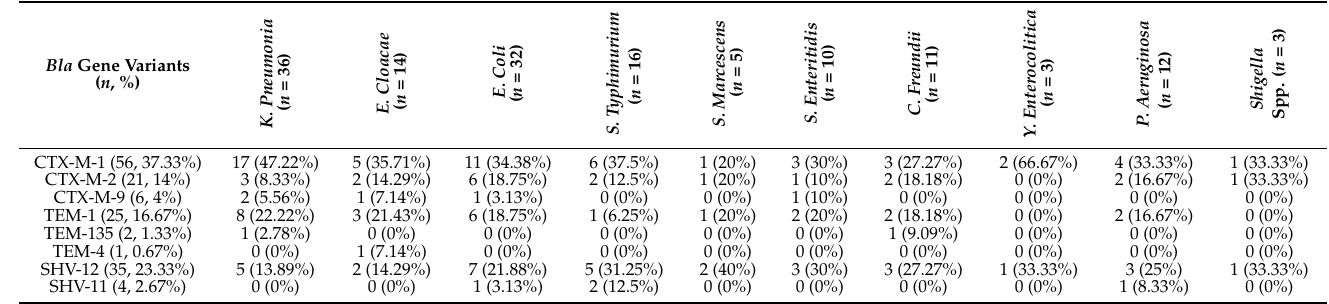
Table 4. Distributions of ESBL bla gene variants ( n = 150).